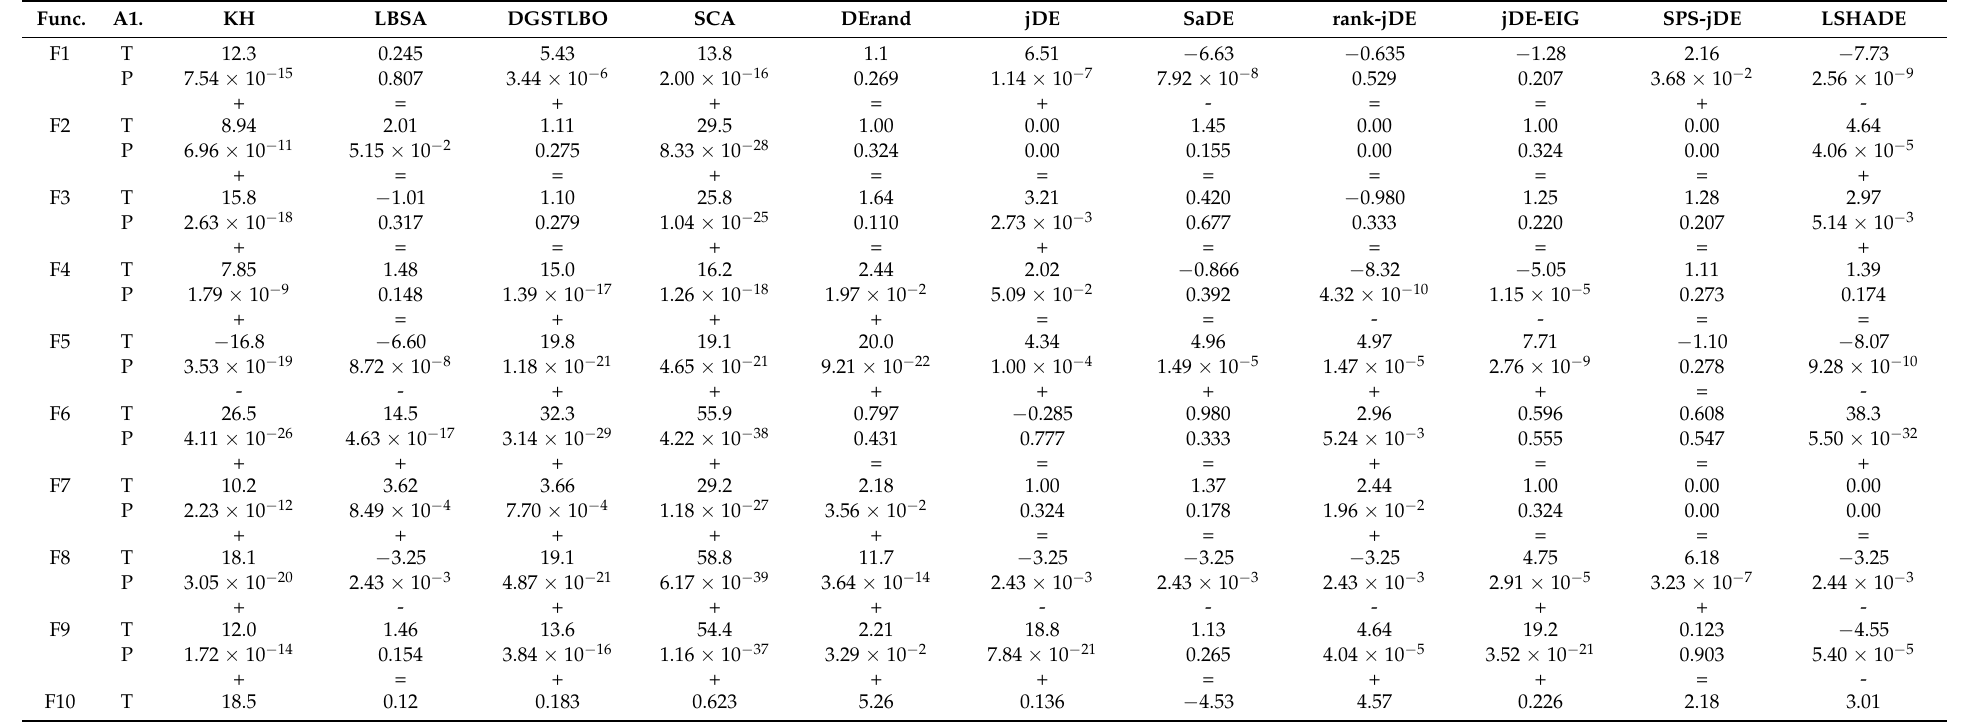
Table 4. Comparison between RUSDE and other algorithms using a t -test with double tail for 30-dimensional